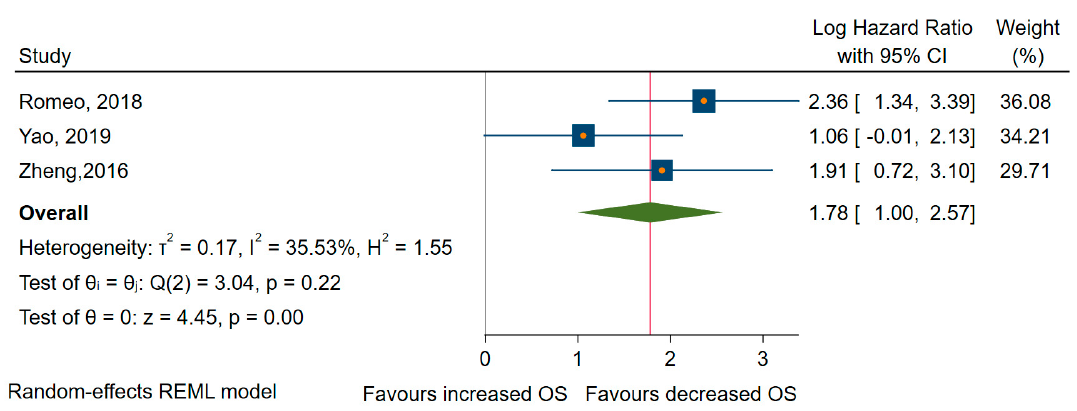
Figure 6. Forrest plot of the association between the upregulated miRNAs and OS.